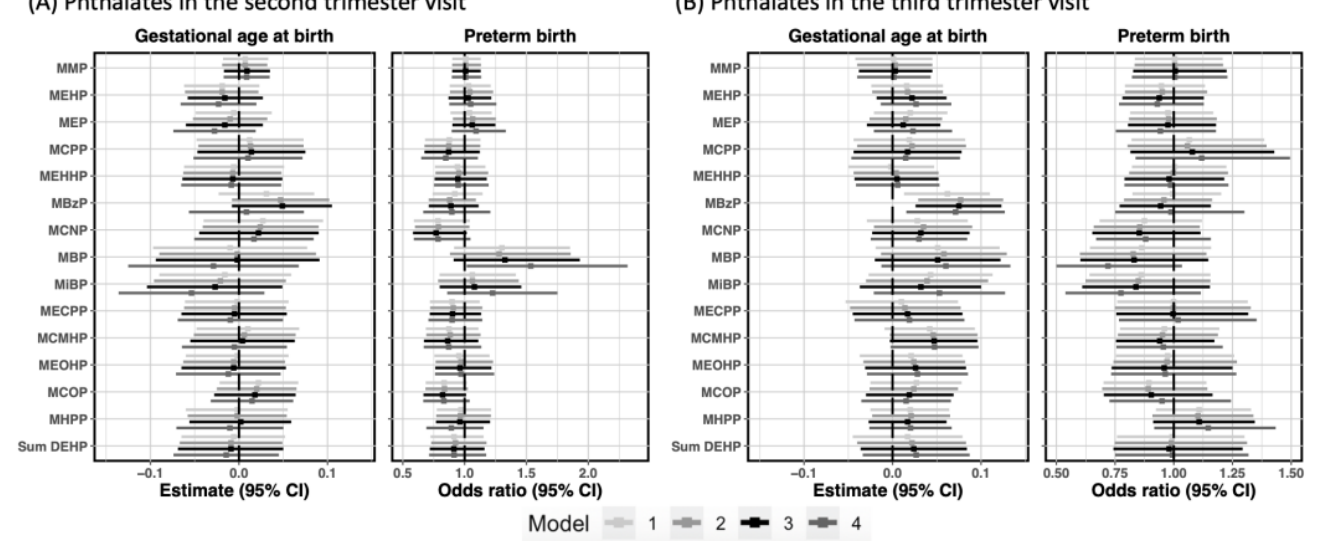
Figure 3. Estimated associations between prenatal phthalates in each visit and birth outcomes in CANDLE participants with a spontaneous labor. Model 1 adjusted for maternal race (Black vs.